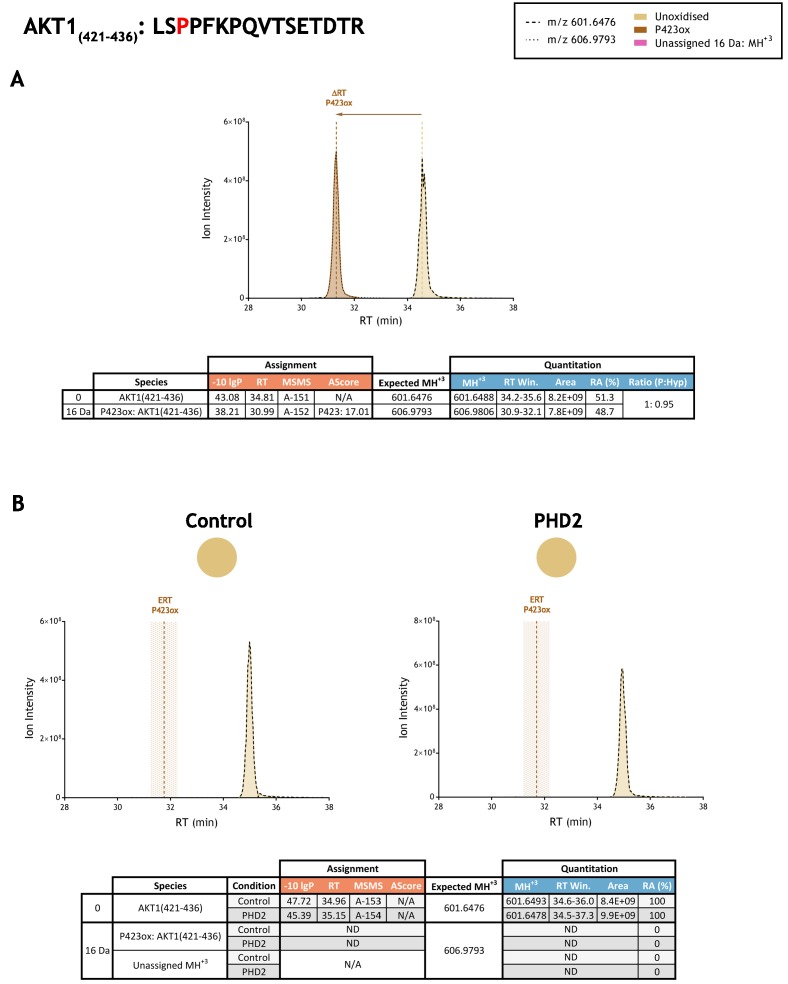
Quantitation of peptide oxidation on AKT1(421–436) following reaction of full-length AKT serine/threonine kinase 1 with recombinant PHD2.XIC data presented in (A) shows ion intensity and retention time (RT) characteristics of equimolar synthetic peptide standards for unoxidised and P423ox forms of the AKT(421-436) peptide. MSMS assigned species are coloured (see inset); vertical dashed lines define peak maxima used to derive ΔRT values for P423ox. Panel (B) shows comparable XIC data for protease-digested IVTT substrate under control (left) or PHD2-reacted (right) conditions. Peaks corresponding to unoxidised AKT1(421–436) were assigned by MSMS (see inset for colour code); P423ox was not detected. The estimated RT (ERT) for P423ox, derived from (A), is indicated by dashed vertical line, shading corresponds to a 1 min RT window. Unassigned ions with a compatible mass over charge for oxidation were not observed across the elution window. Quantitative data for observed species are presented as pie charts with XIC data. Assignment and quantitation data are tabulated below each panel, table headers are as follows: (−10lgP) significance score of leading assignment at given (RT) with ambiguity score (AScore) for PTM localisation and reference to primary MSMS data in Supplementary file 1. Quantitative data reports ion counts (Area) of observed masses (MH+3) integrated over time (RT Win.), expressed as relative abundance (RA). Data on detection efficiency for synthetic peptides (Panel A, P: Hyp) is an aggregated ratio of prolyl (P) to hydroxyprolyl (Hyp) containing species.